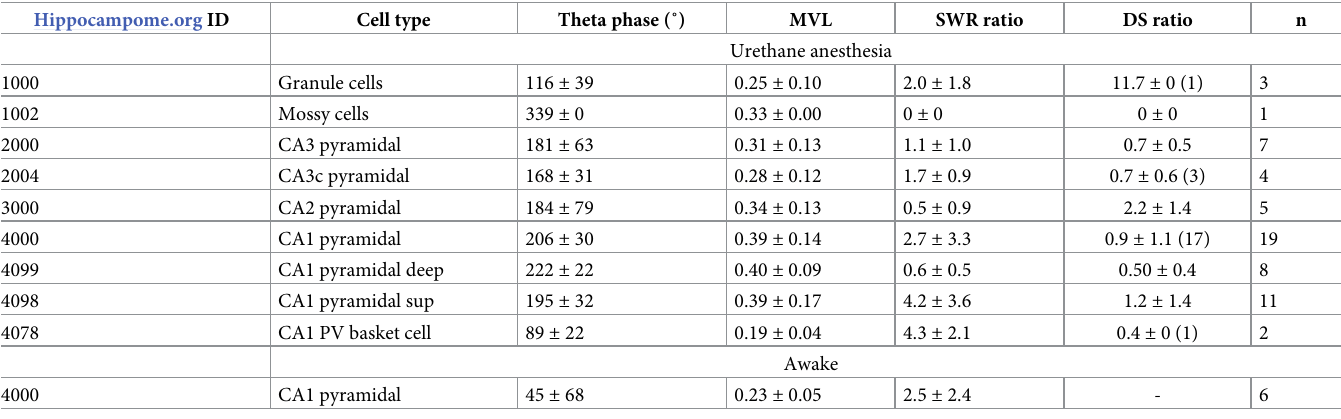
Table 2. Network firing properties per hippocampal cell types (sharp intracellular recordings). Hippocampome.org